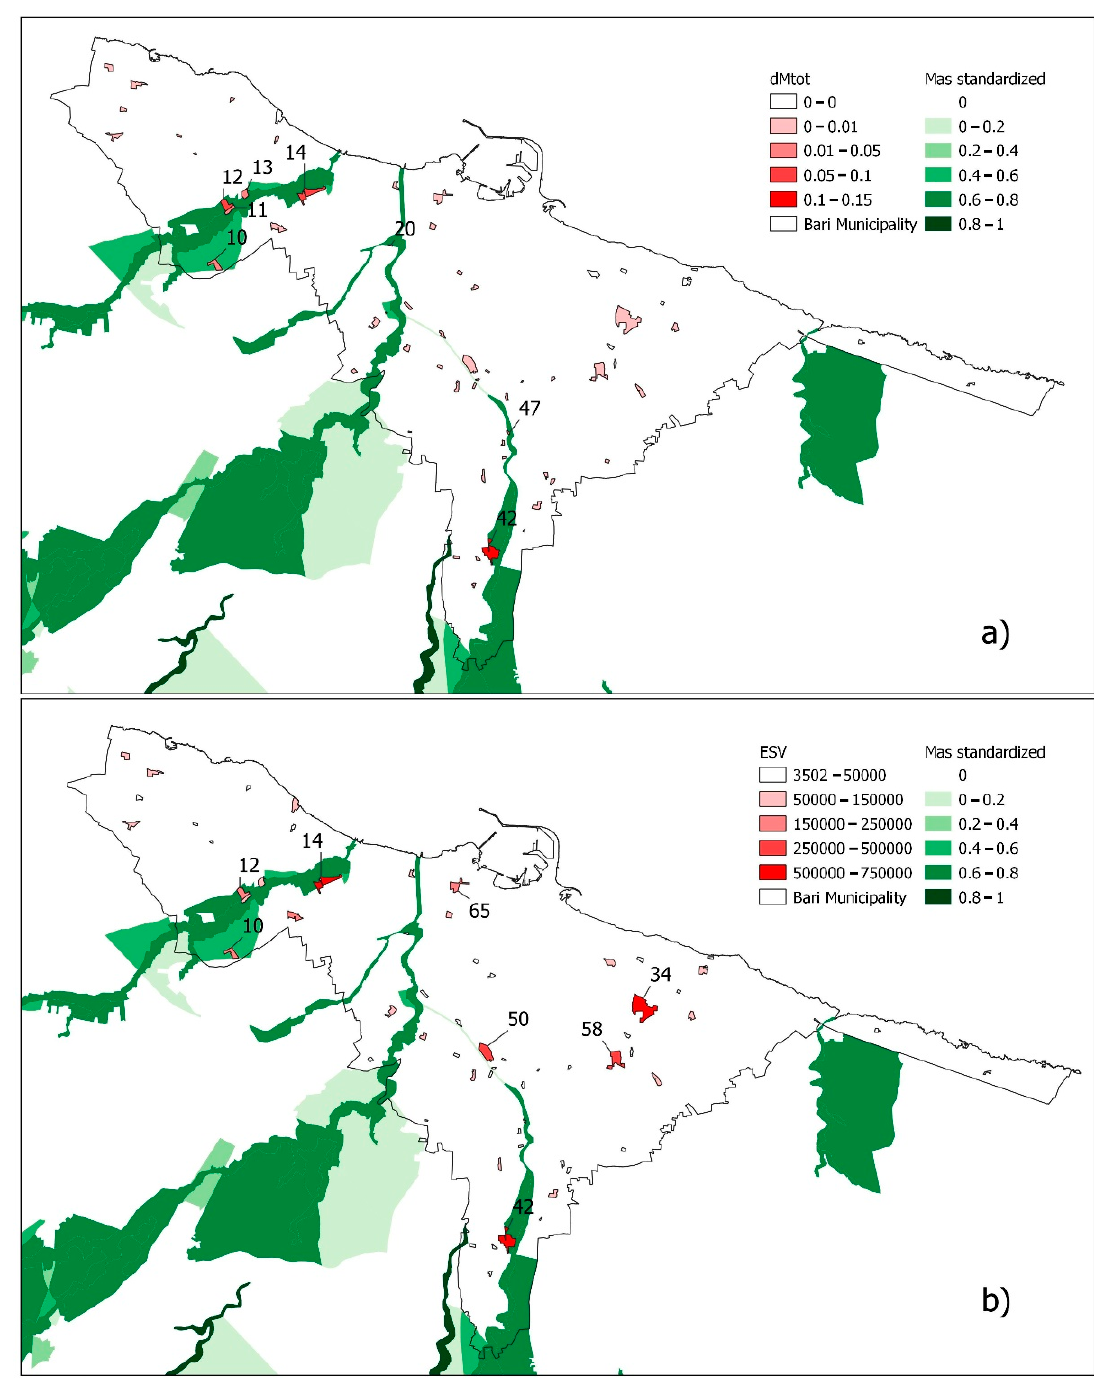
Figure 10. Spatial visualization of NUA assessment using CORINE fourth level thematic aggregation. ( a ) dMtot index; ( b ) Ecosystem Service Value (ESV) for biodiversity conservation. Numbers represent the ID of the first ranked NUAs.